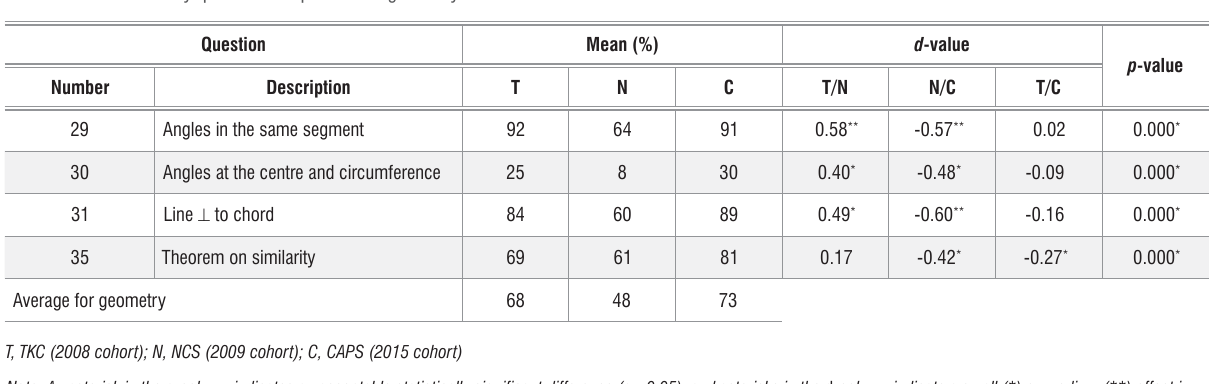
Differentiation